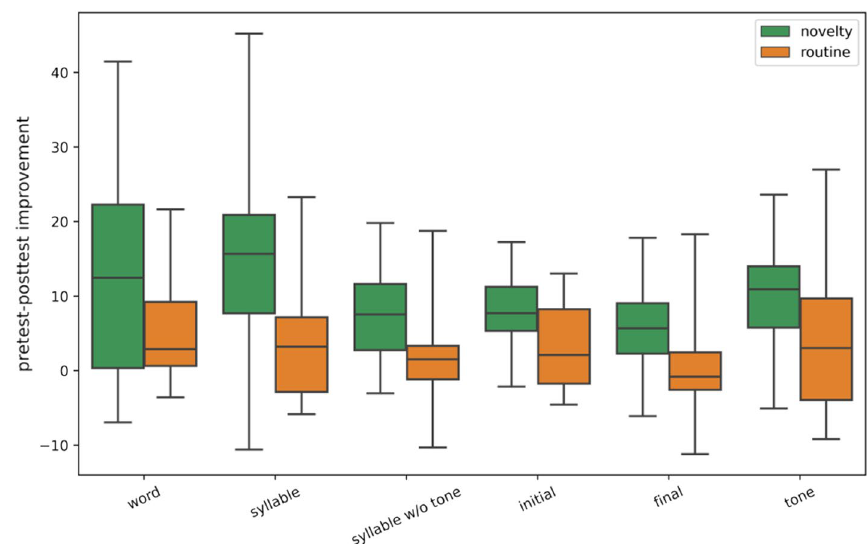
Fig. 5 Intermediate learners’ pretest-delayed posttest improvements under the two training conditions